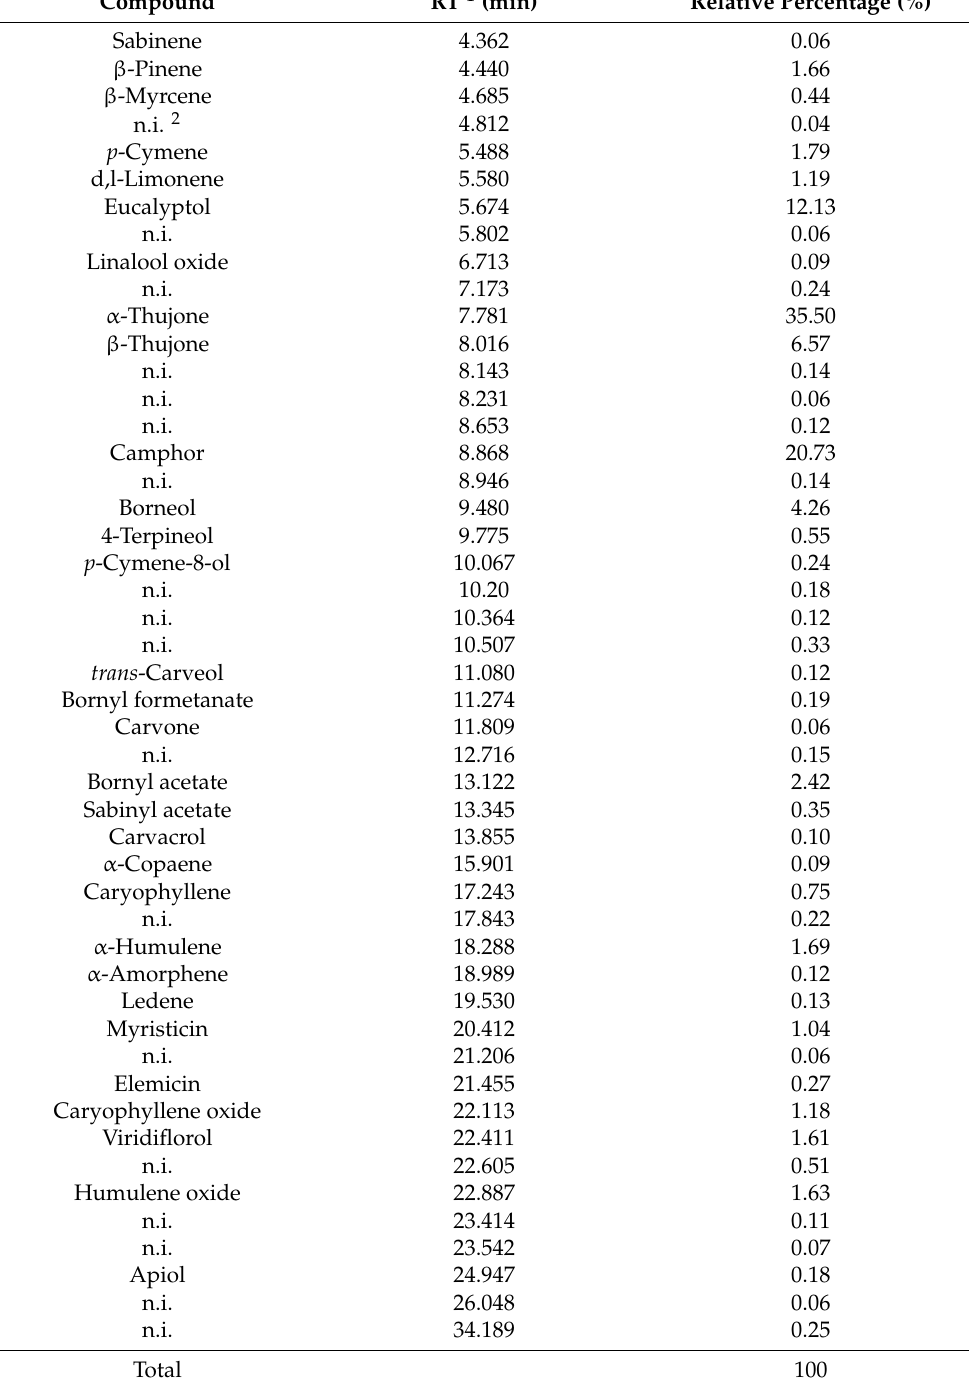
Table 1. Chemical profile of sage essential oil determined by gas chromatography–mass